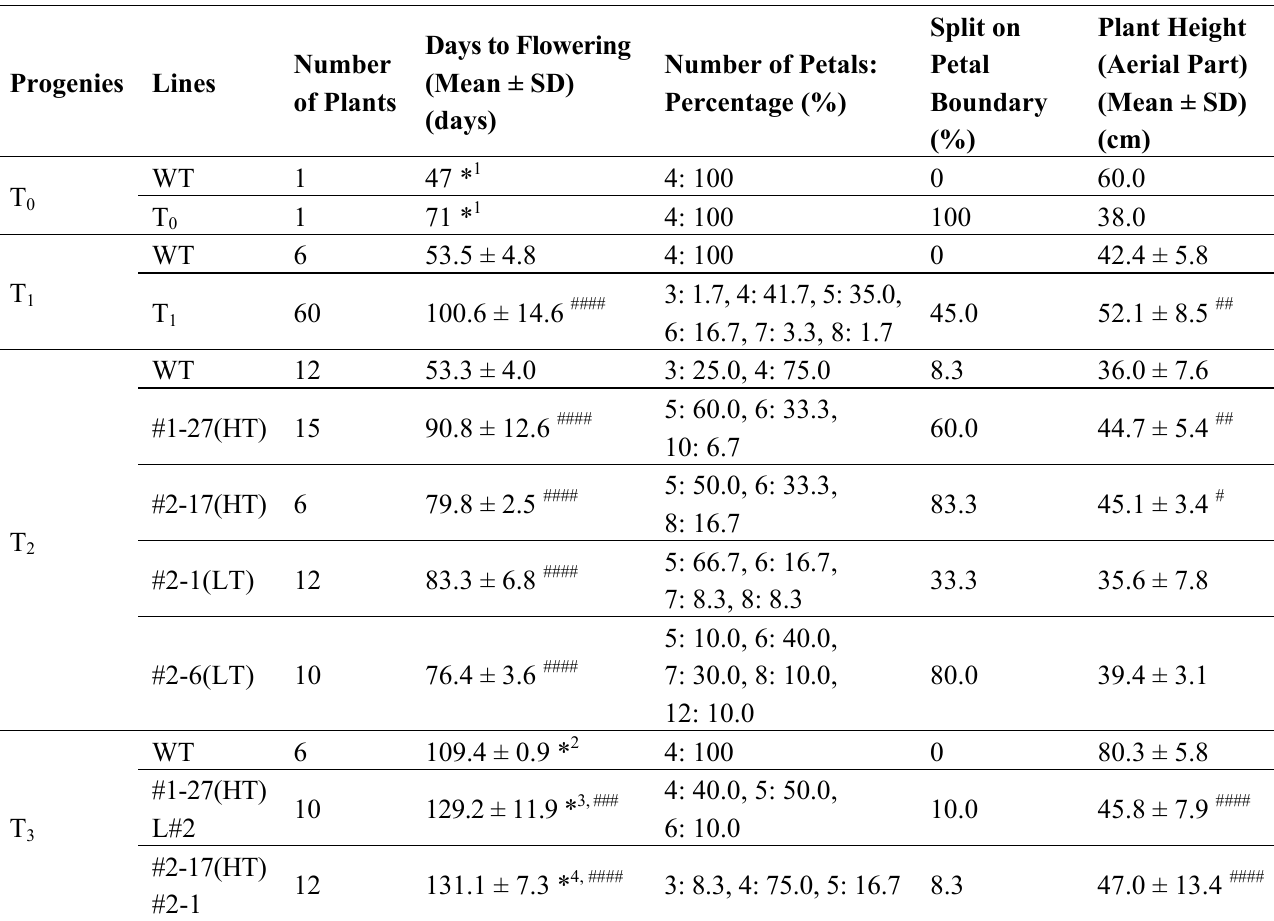
Table 1. Summary of the morphological characteristics of PsM1-2 T progenies, and WT